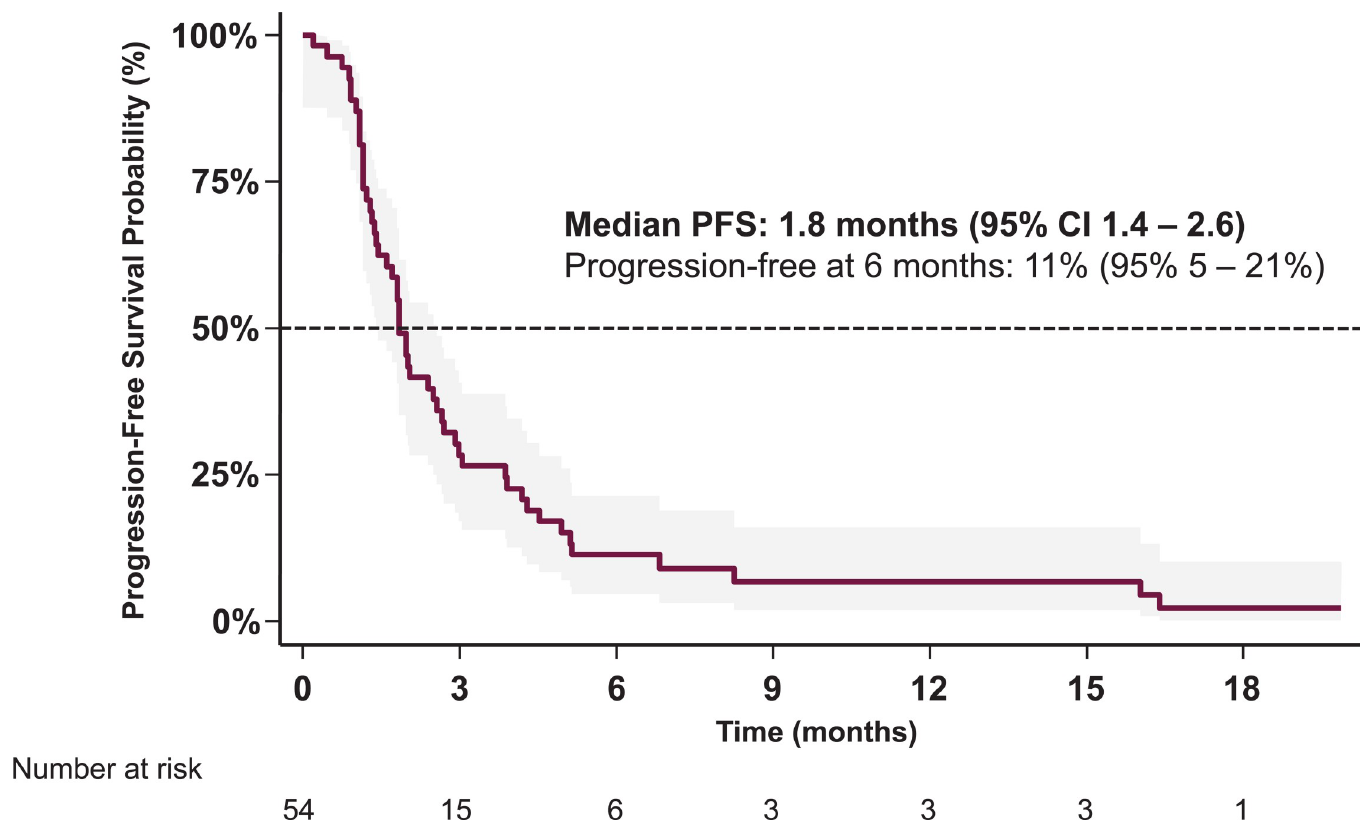
Fig 2. Progression-free survival (PFS) during erlotinib therapy (with 95% CI).